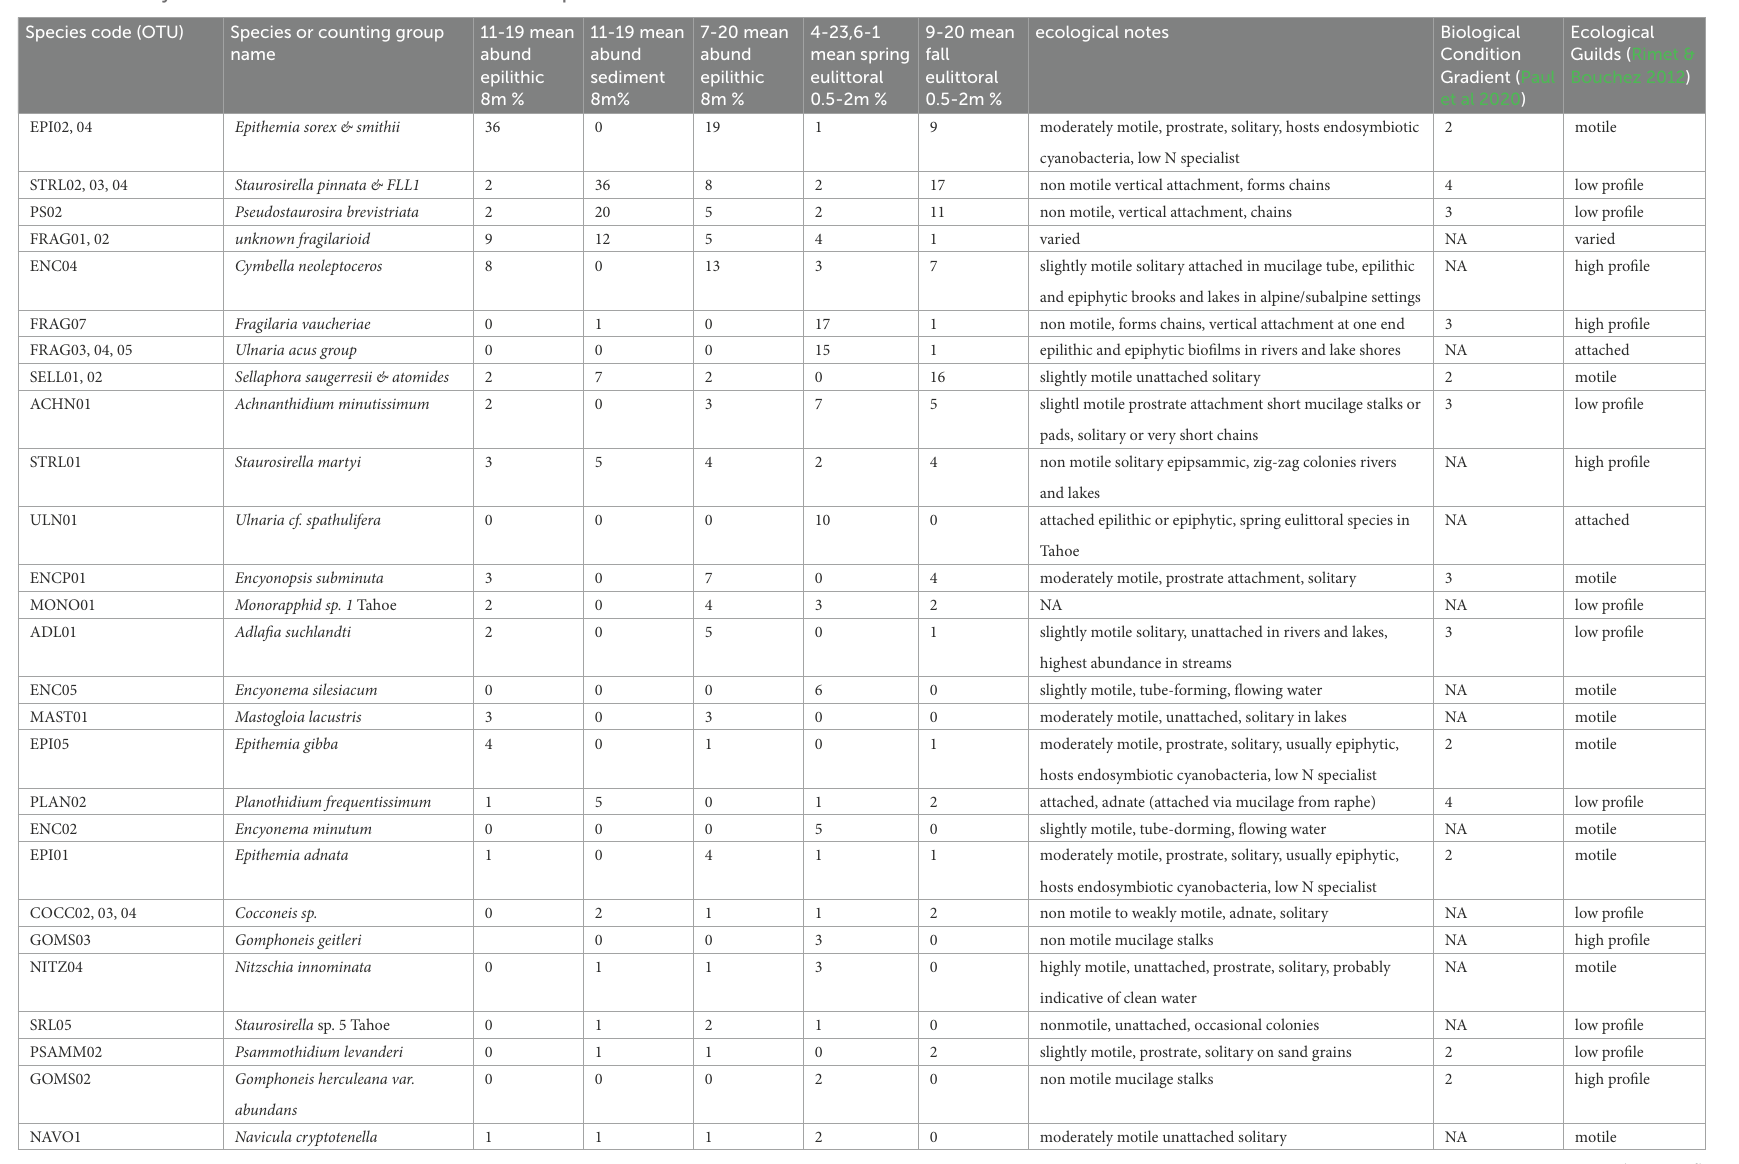
TABLE 4 Summary counts of diatoms from seasons and habitats reported as % relative